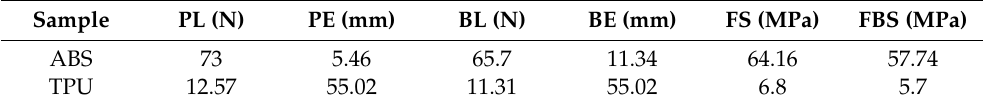
Table 4. Flexural properties of pure ABS and TPU specimen.